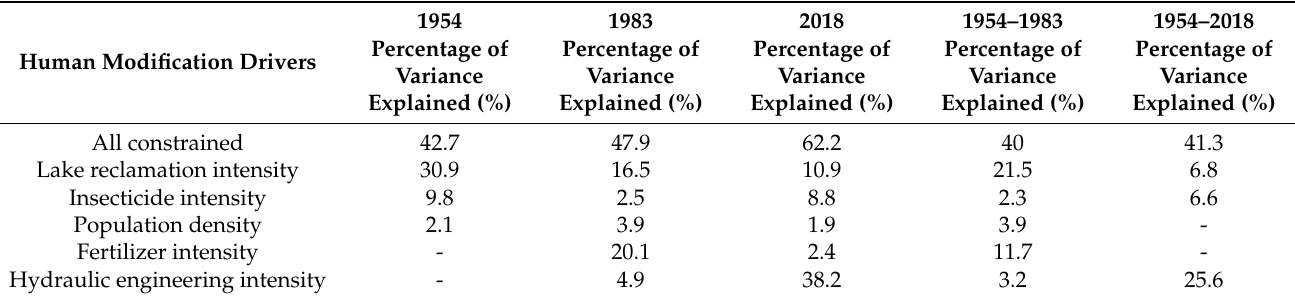
Table 2. Redundancy analysis in a different single year or the change of two-time steps (1954,